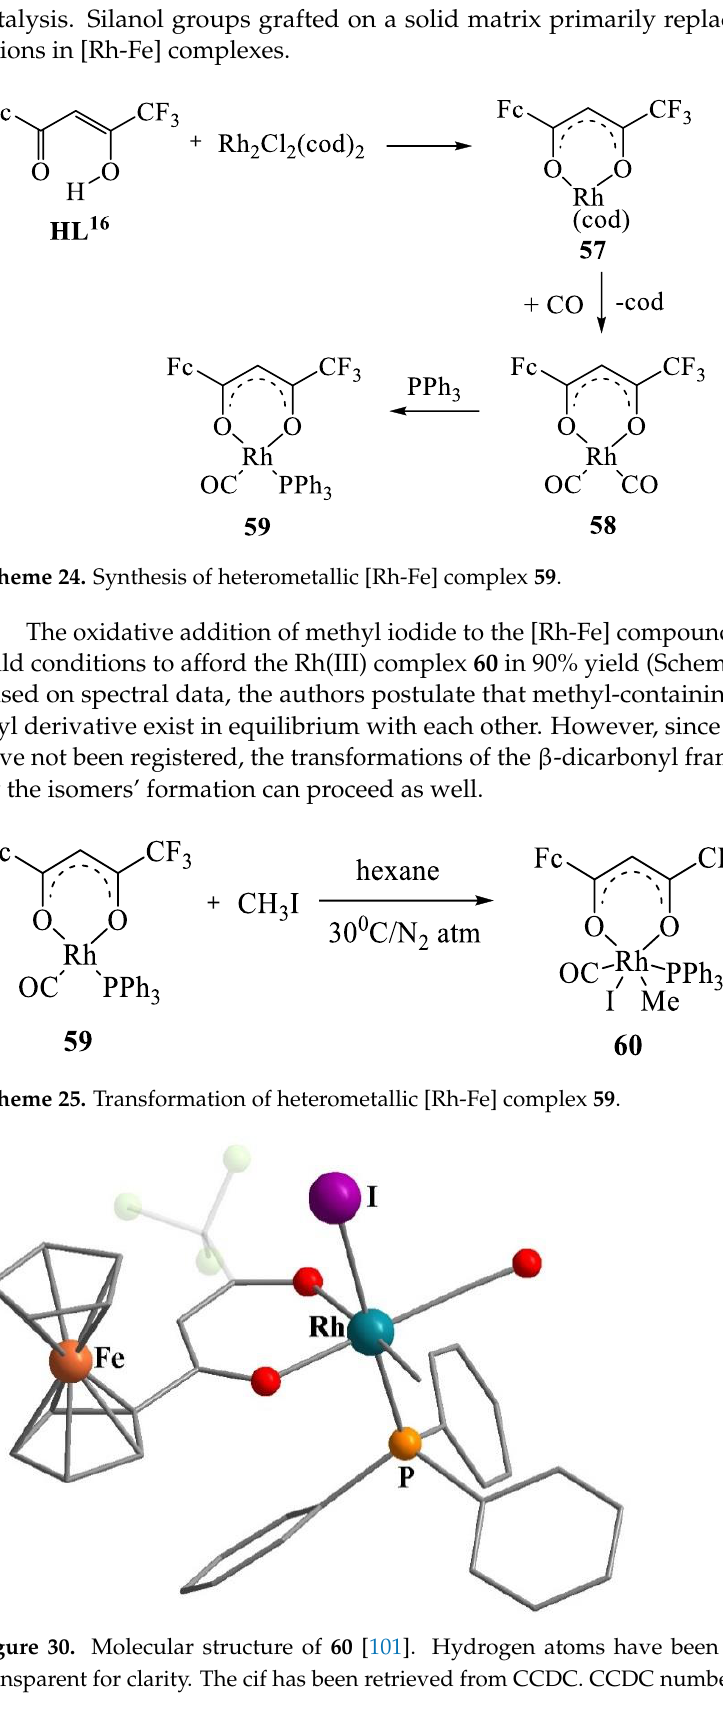
Figure 30. Molecular structure of 60 [101]. Hydrogen atoms have been omitted, CF 3 group is trans- parent for clarity. The cif has been retrieved from CCDC. CCDC number is 646438.